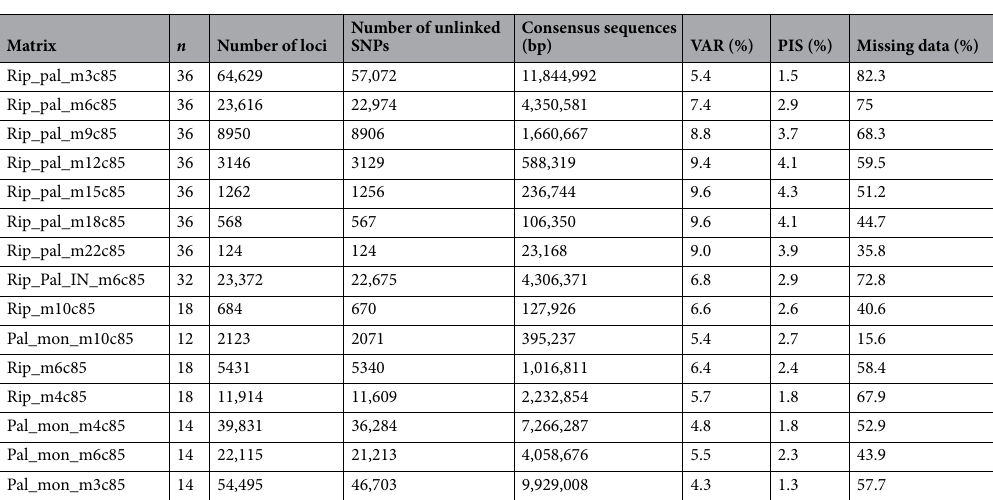
Table 1. Summary of the ddRADseq datasets used in the downstream analysis. n: number of individuals; VAR: percentage of variable sites; PIS: percentage of parsimony informative sites. Dataset names are organized as following: Rip_pal— pullata and monticola groups combined plus outgroup species; Rip_pal_IN—same as previous but no outgroup; Rip— pullata group only; Pal_mon— monticola group only; m—minimum taxon coverage; c—clustering